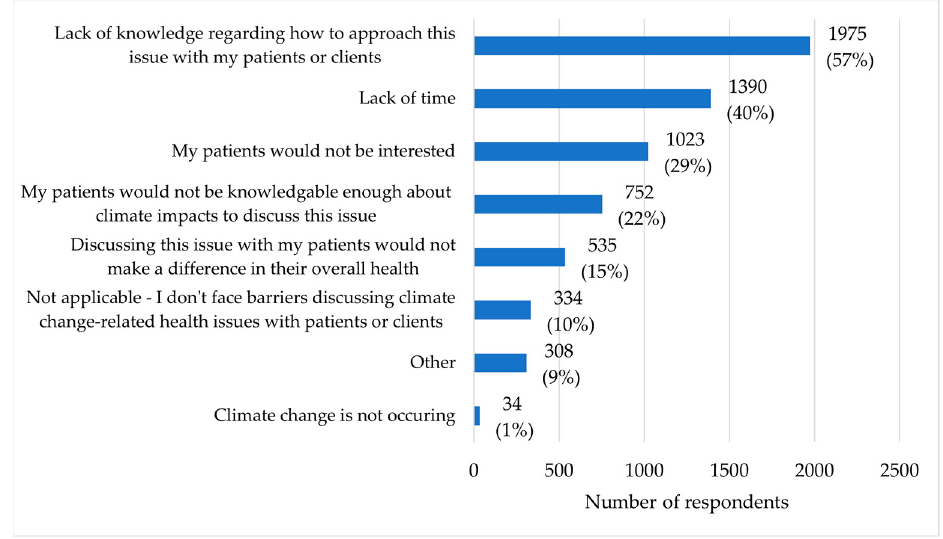
Figure 3. Barriers to discussing climate change with patients or clients (n = 3381).